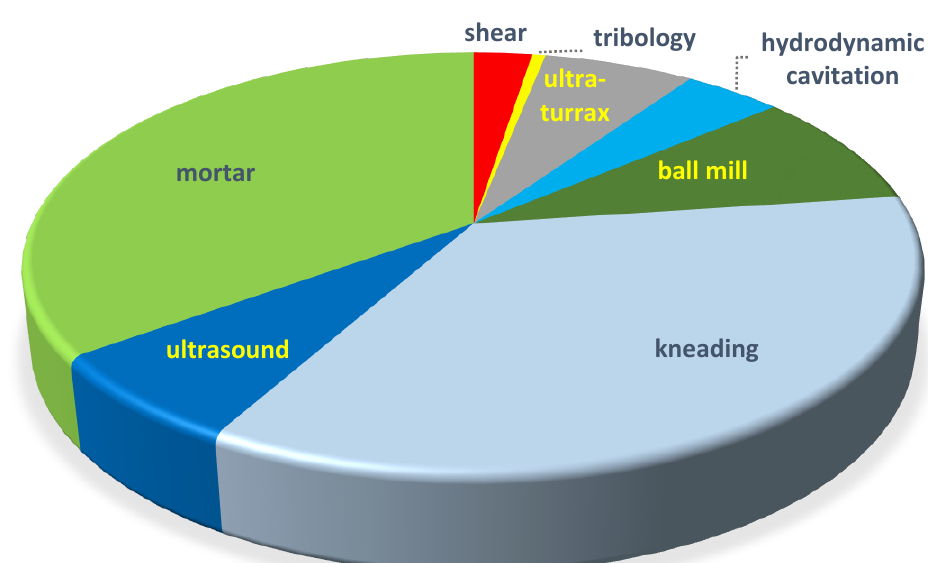
Figure 1. Distribution of various complexations in the technical papers till 28 July 2021. Due to the overlaps of some topics, such as grinding and kneading, hydrodynamic cavitation/ultra-turrax, and ultrasonic mixing, the percentages carry little information.